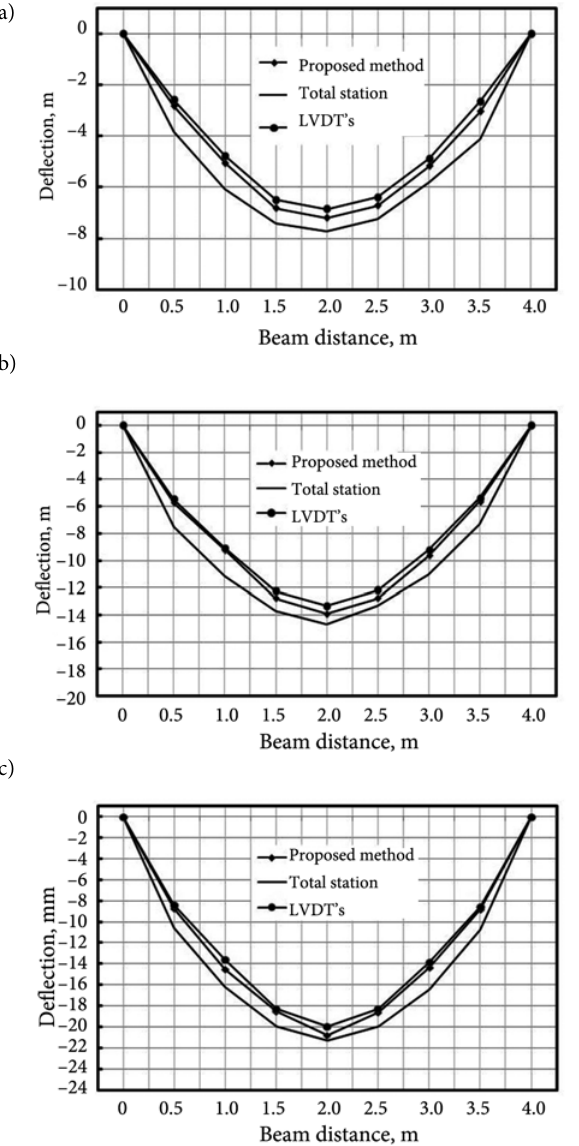
Fig. 3. Plots of the beam deflections for a) 0.5 ton